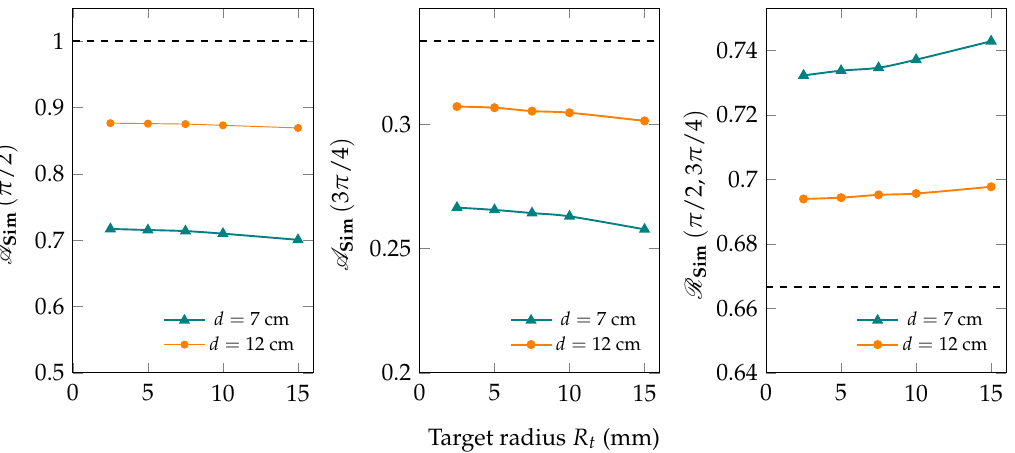
Figure 6. Dependence of the asymmetries A Sim ( π /2 ) and A Sim ( 3 π /4 ) , and the angular distribution ratios R Sim ( π /2,3 π /4 ) on the target length at different target-to-detector distances for the dipole transition with a spin sequence of 0 → 1 → 0. The detector radius is fixed at R d = 45 mm while λ t = 5 mm. The exact values corresponding to the point target and point detector are expressed by dashed